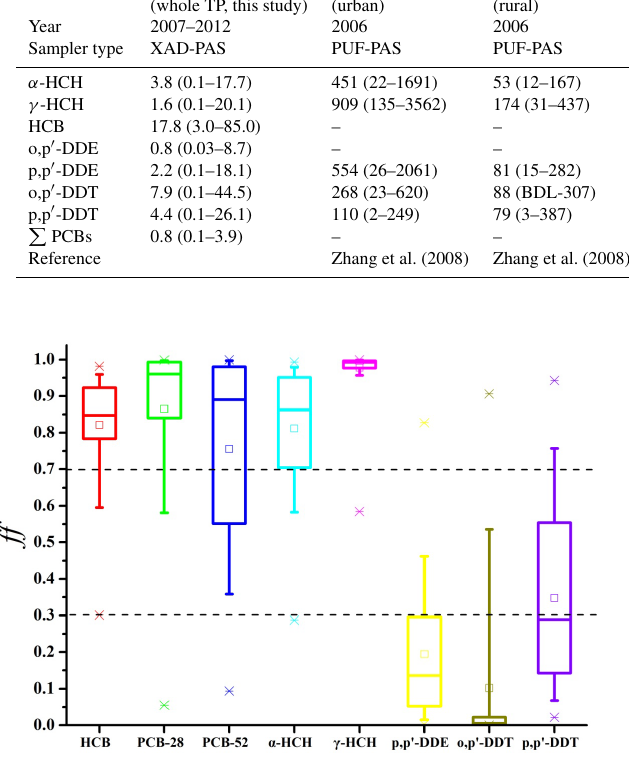
Figure 3. Air–soil fugacity fraction (ff) of individual compounds across the TP. The boxes are defined by the 25th and 75th per- centiles; whiskers mark the 10th and 90th percentiles; the median is represented by a horizontal line; the mean by a square; and out- liers with an